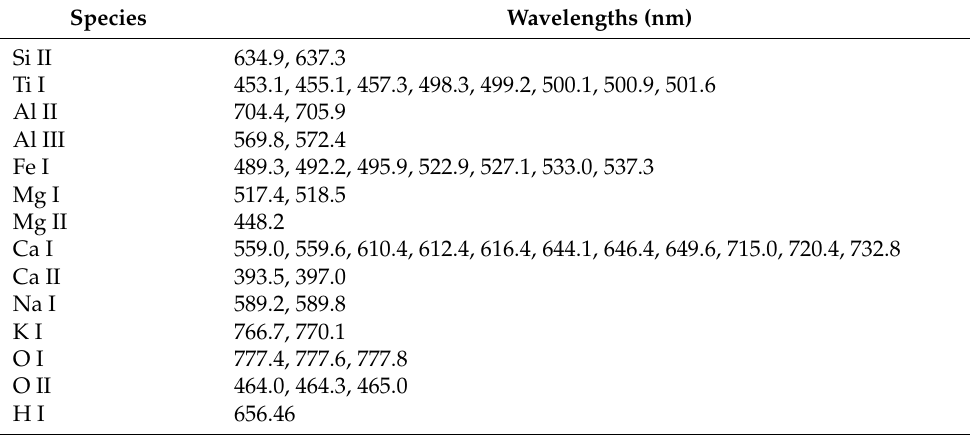
Figure 5. VOILA spectra of Moon analogue samples LMS-1, LHS-1, ilmenite, dunite, anorthosite, oligoclase, goethite, and limonite, plotted with a vertical offset for visual clarity. Each spectrum was obtained by averaging ten individual spectra measured at different positions on the sample. Signif- icant spectral lines are marked by vertical lines. Table 3. Strongest emission lines of the plasma species observed in the VOILA spectra shown in Figure 5.